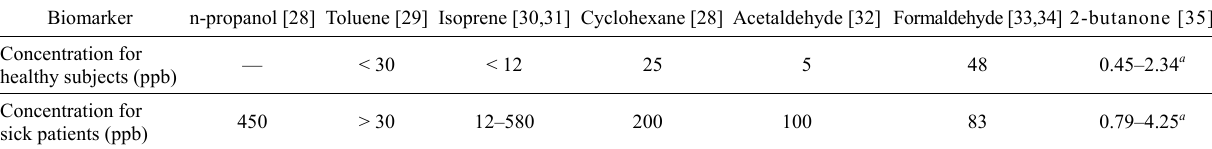
Table 1 Gas concentrations of LC patients and healthy people